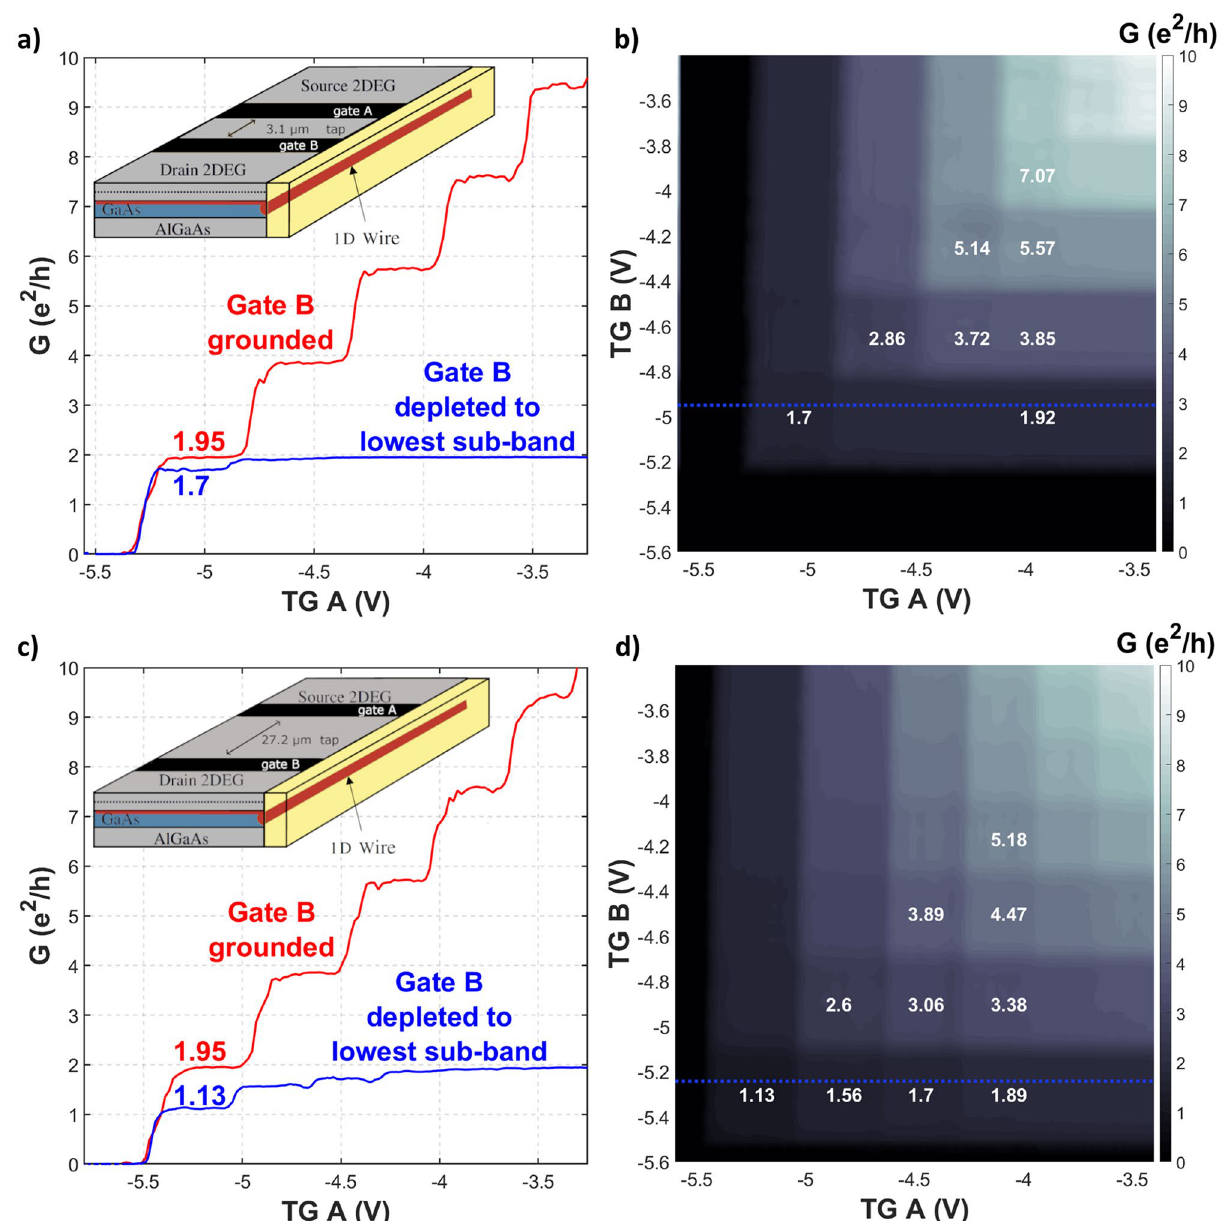
Figure 4. Measurements at 25 mK using an ac excitation of 6 μV over two wires A and B separated by a tap of two different widths. ( a ) Conductance dependence of top-gate A at a side-gate voltage of 2.3 V, for solely wire A (top-gate B on ground, red line) and for wire B tuned to the lowest sub-band with W = 3.1 μm (blue). A mixture of ballistic and diffusive transport can be observed. The inset shows a schematic of the device. ( b ) Contour plot of conductivity as function of both top-gate voltages. The blue line shows the cut from a) where wire B is tuned to the lowest sub-band. ( c , d ): Analog to ( a ) and ( b ) but with W = 27.2 μm. A pronounced check-board pattern indicating mostly diffusive transport can be